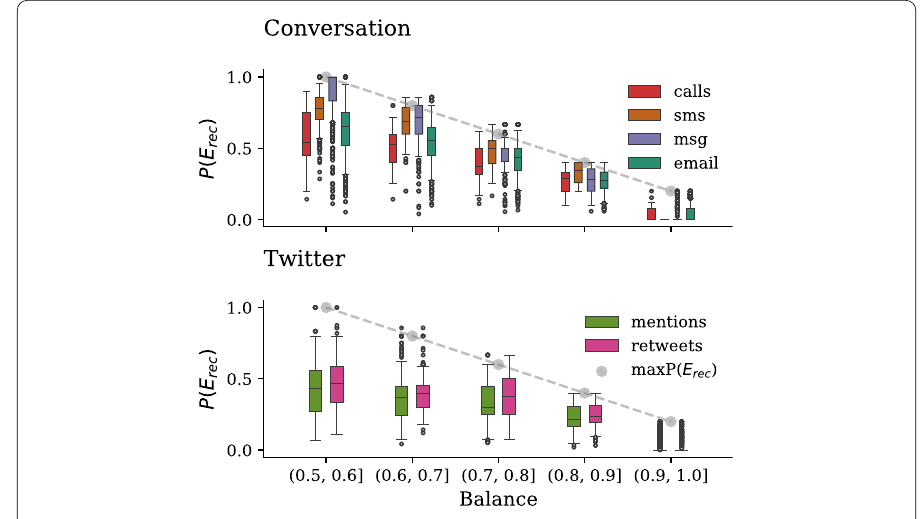
Figure 2 Balance as upper bound of reciprocity in temporal networks. Distribution of fraction of reciprocations p ( E rec ) over nodes in dataset (box plot), and approximate upper bound p ( E rec ) = 2(1 – b )